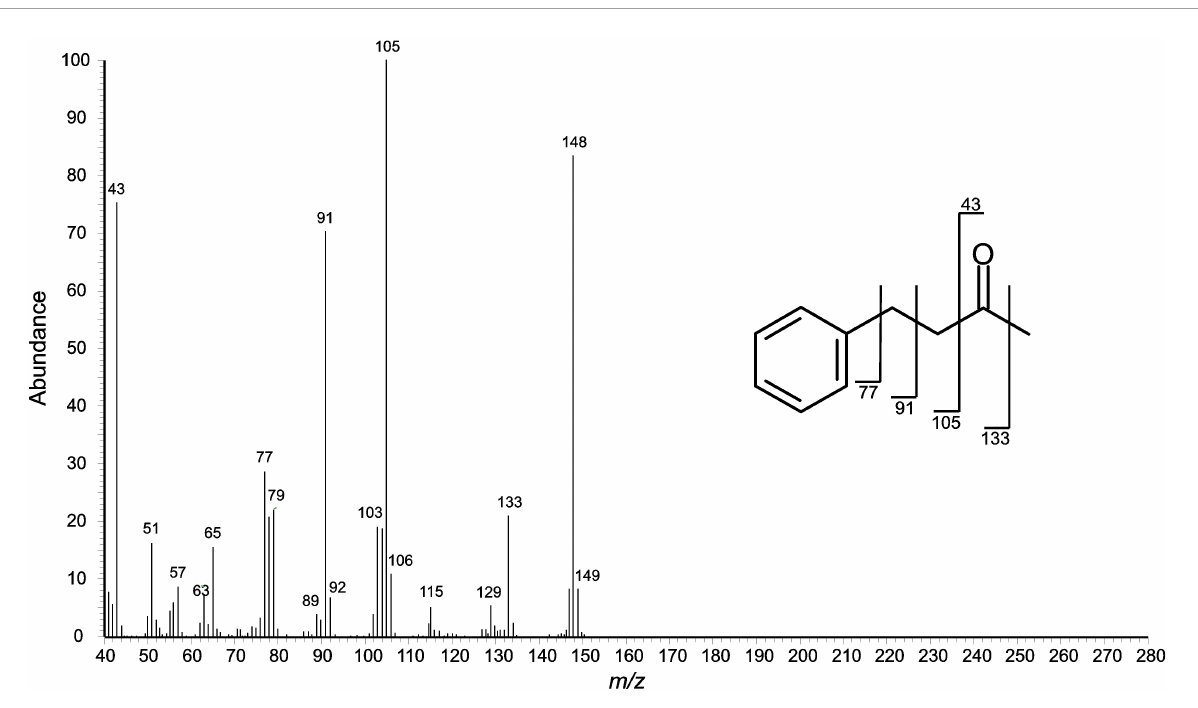
FIGURE3 Mass spectral (EI) fragmentation of aromatic compound D (4-phenyl-2-butanone). Fragment ions from α -cleavage can be seen at m/z 43 and 133.